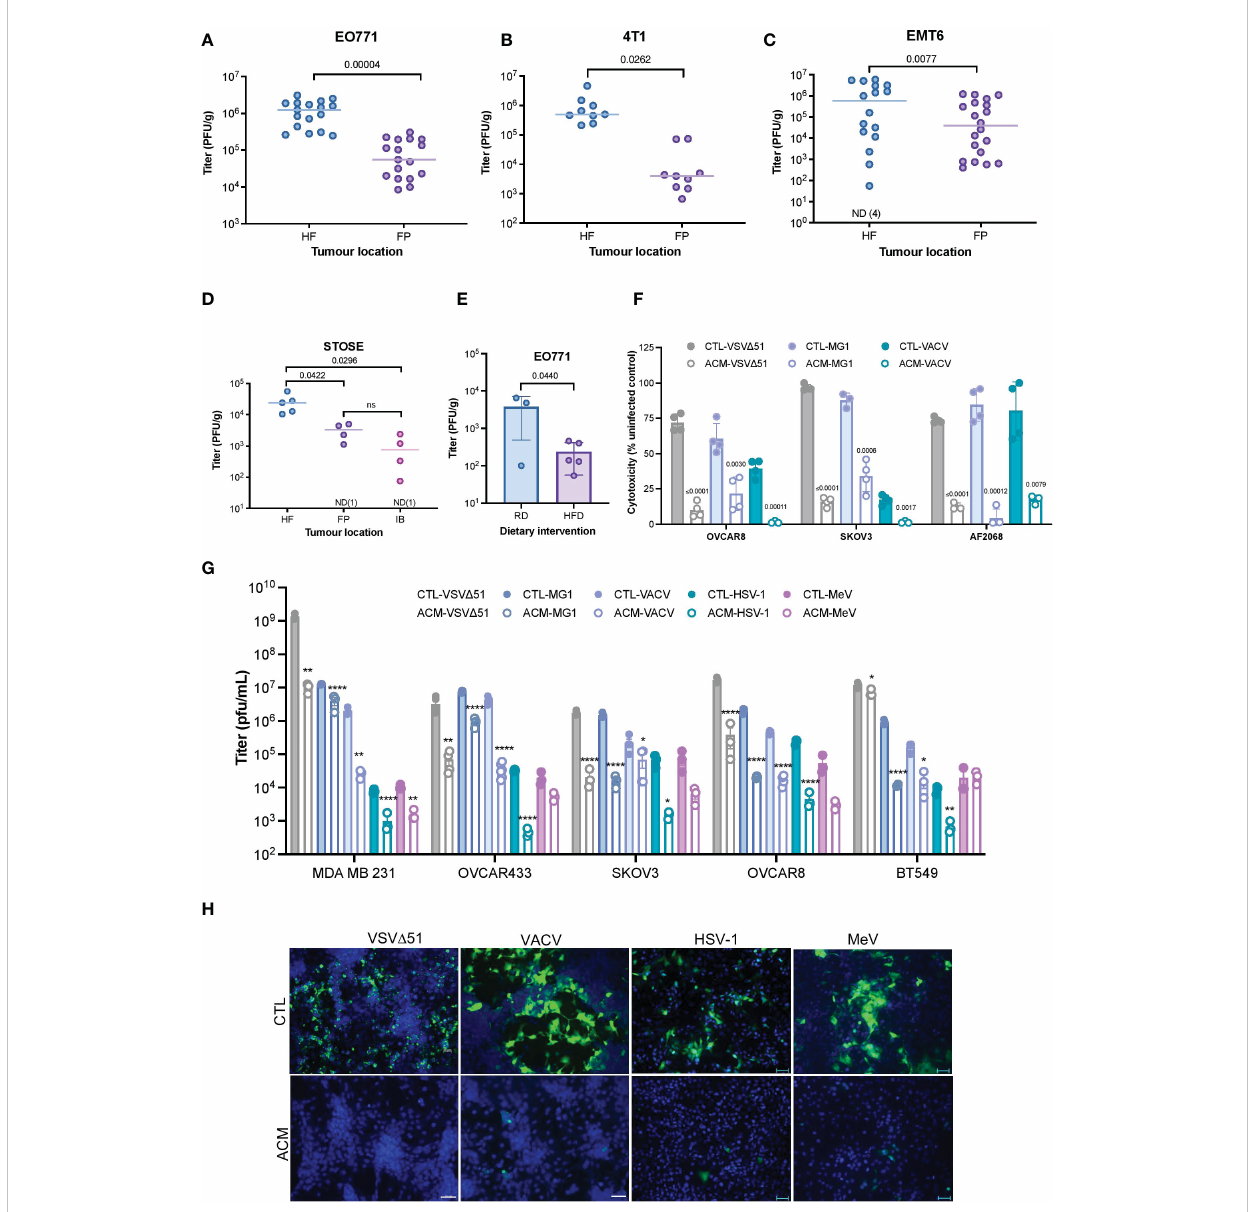
FIGURE 1 A Fatty TME correlates with OV resistance. (A – C) Syngeneic EO771 (A) , 4T1 (B) , and EMT6 (C) breast tumors were seeded in the fat-pad (FP) or subcutaneously in the hind fl ank (HF) of Balb/c or C57BL/6 mice. Tumors were intratumorally treated with VSV D 51 [1.5E8 plaque forming units (PFU)/ tumor] and collected after 48 hours for quanti fi cation of infectious particles. ND, non-detected. Two-tailed, unpaired t-test. (D) STOSE cells were seeded in the HF, FP or intrabursally (IB) in FVB/N mice and treated with Maraba MG1 (1E7 PFU/tumor). Tumors were harvested 72 hours post- infection (hpi) for virus quanti fi cation by plaque assay. ND, non-detected. Lines indicates the median. One-way ANOVA, Tukey ’ s multiple comparison test. (E) Following a period of high-fat or regular diet feeding of C57BL/6 mice, EO771 cells were seeded in the FP. Tumors were intratumorally treated with Maraba MG1 (5E8 PFU/tumor) and harvested for quanti fi cation by plaque assay 48 hpi. Two-tailed, unpaired t-test. (F) Relative percentage (% compared to uninfected cells) of VSV D 51-induced cytotoxicity in OVCAR8, SKOV3, and a primary ovarian cancer cell culture (AF2068) cultured in a regular growth medium (CTL) or a human breast adipocyte-conditioned medium (ACM) for 16 hours prior to infection with indicated OVs (48 hours, MOI 0.1). Results are displayed as mean ± SEM of four biological replicates. Two-tailed, unpaired t-test for each CTL and ACM pair. (G) Oncolytic virus titers from an OV-infected panel of breast and ovarian cancer cell lines [OVCAR8, MDA MB 231 and SKOV3 (MOI 0.1, 48 hpi), and OVCAR433 and BT549 (MOI 1, 48 hpi)] cultured in a regular growth medium or ACM were quanti fi ed by plaque assay. Data indicate the mean ± SEM of 3 to 5 biological replicates. Two-tailed, unpaired t-test for each CTL vs ACM pair. *p <0.05, **p<0.01, *p<0.05, **p<0.01, ****p<0.0001. (H) Representative immuno fl uorescence microscopy images of OV-infected (VSV D 51 MOI 0.1 24 hpi, VACV MOI 0.1 48 hpi, HSV-1 MOI 0.1, 48 hpi, MeV MOI 1, 48 hpi) OVCAR8 cells are shown (VSV D 51 and VACV, scale bar 20 m m; HSV-1 and MeV scale bar represents 50 m m). ns, non-signi fi